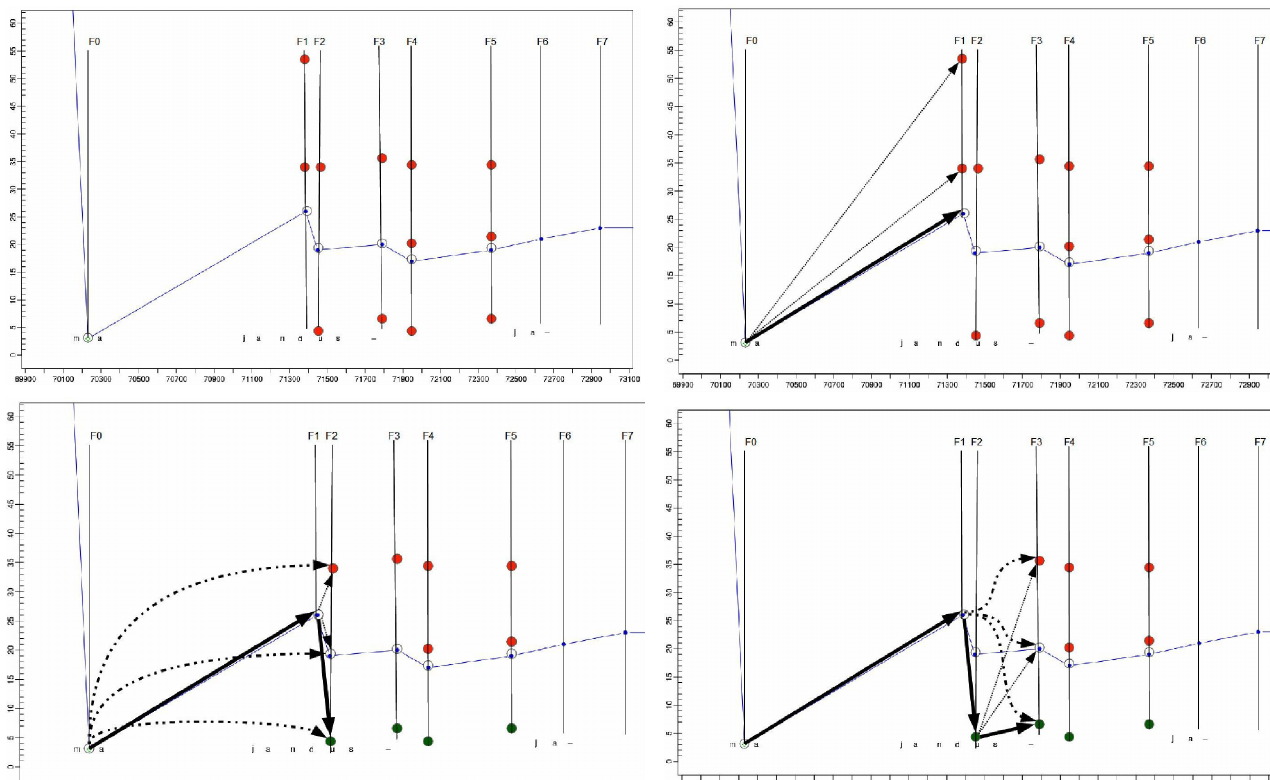
Figure 3a to 3d from top left to bottom right: Figure 3a shows the projection of the naïve mapping into a lattice of alternative fixation-to-symbol re-mappings (red dots). Figure 3b (top, right) plots links to the first successor node, figures 3c (bottom, left) and 3d (bottom, right) show successive steps in the re-mapping algorithm, including links to pre-predecessor